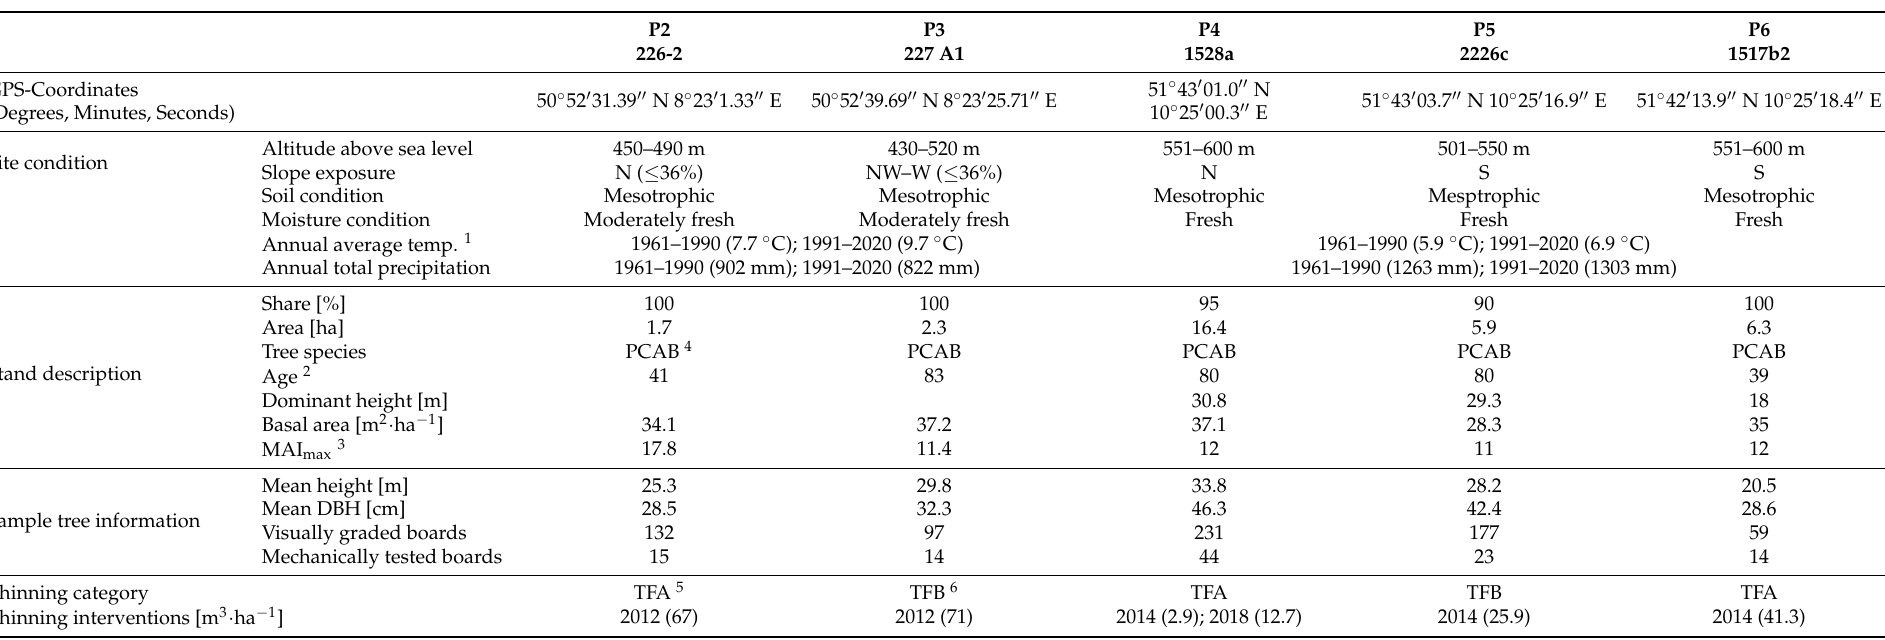
Table 1. Description of the site conditions of the five study sites (P2–P6 with P = plot) from the forest districts Breidenbacher Grund and